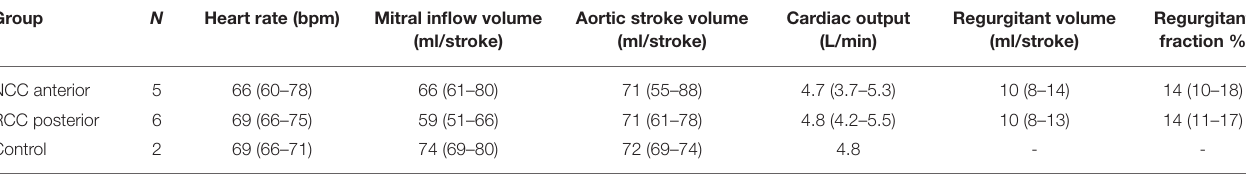
TABLE 1 | Hemodynamic values of animals